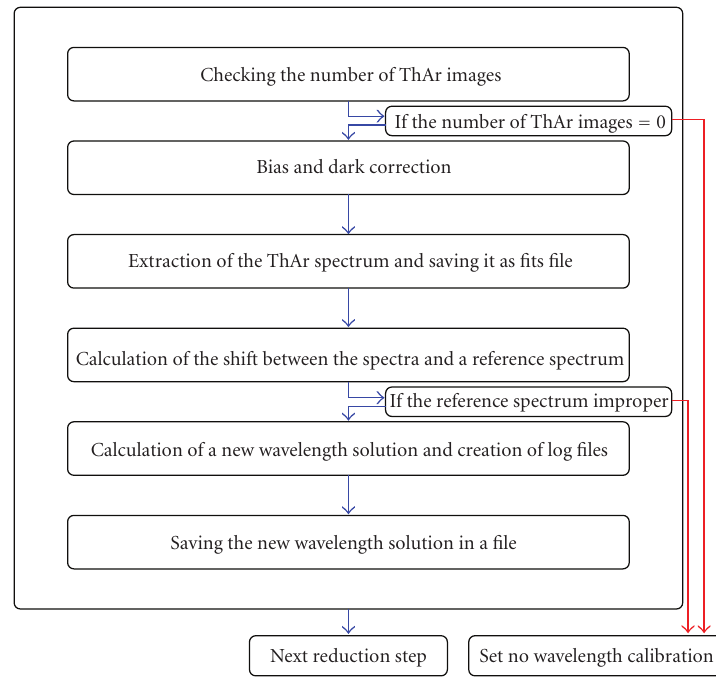
Figure 5: Flow chart with the main steps of the wavelength calibration.